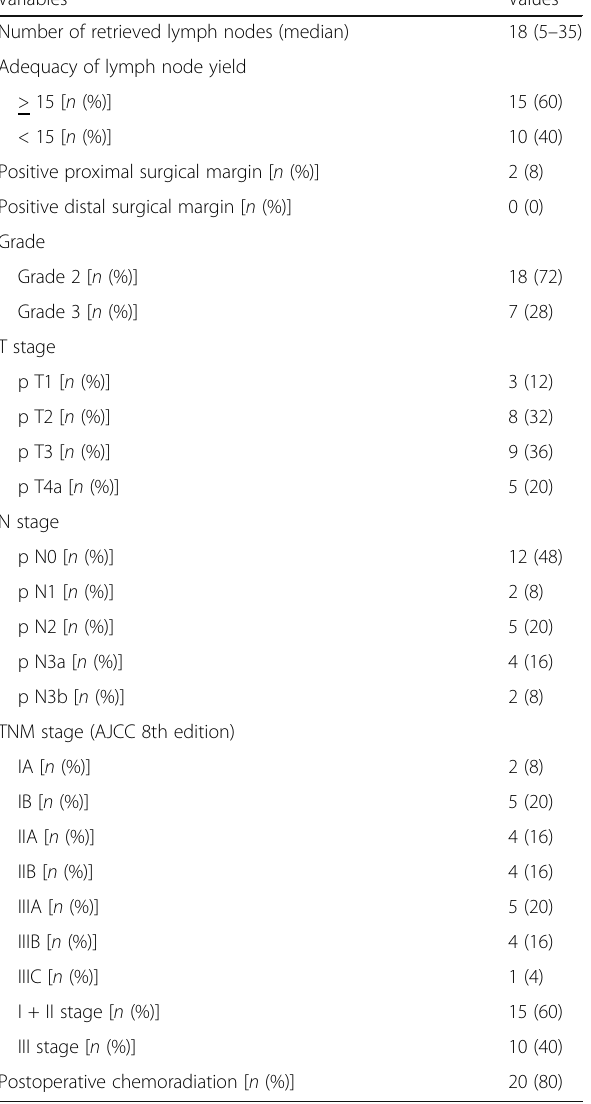
Table 2 Histopathological data ( n = 25) Variables